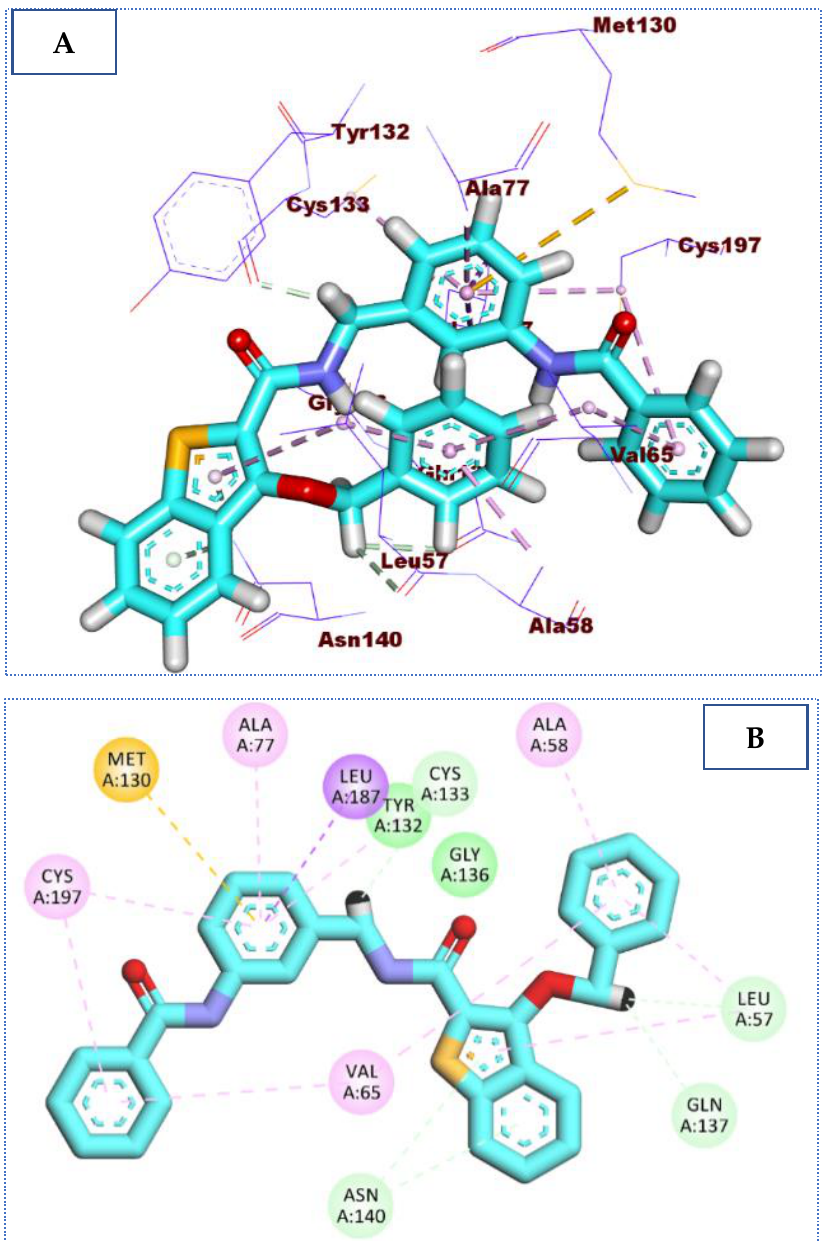
Figure 8. ( A ) The 3D and ( B ) 2D binding of 35 in the active site of BMP-2-inducible kinase (hydrogen bonds = green dashed lines, electrostatic interactions = orange dashed lines, pi-pi interactions = purple dashed lines, and pi-alkyl interactions = light pink dashed lines).